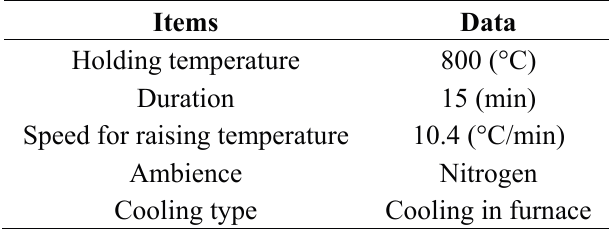
Table 3. Process parameters for ZnO films treated by furnace